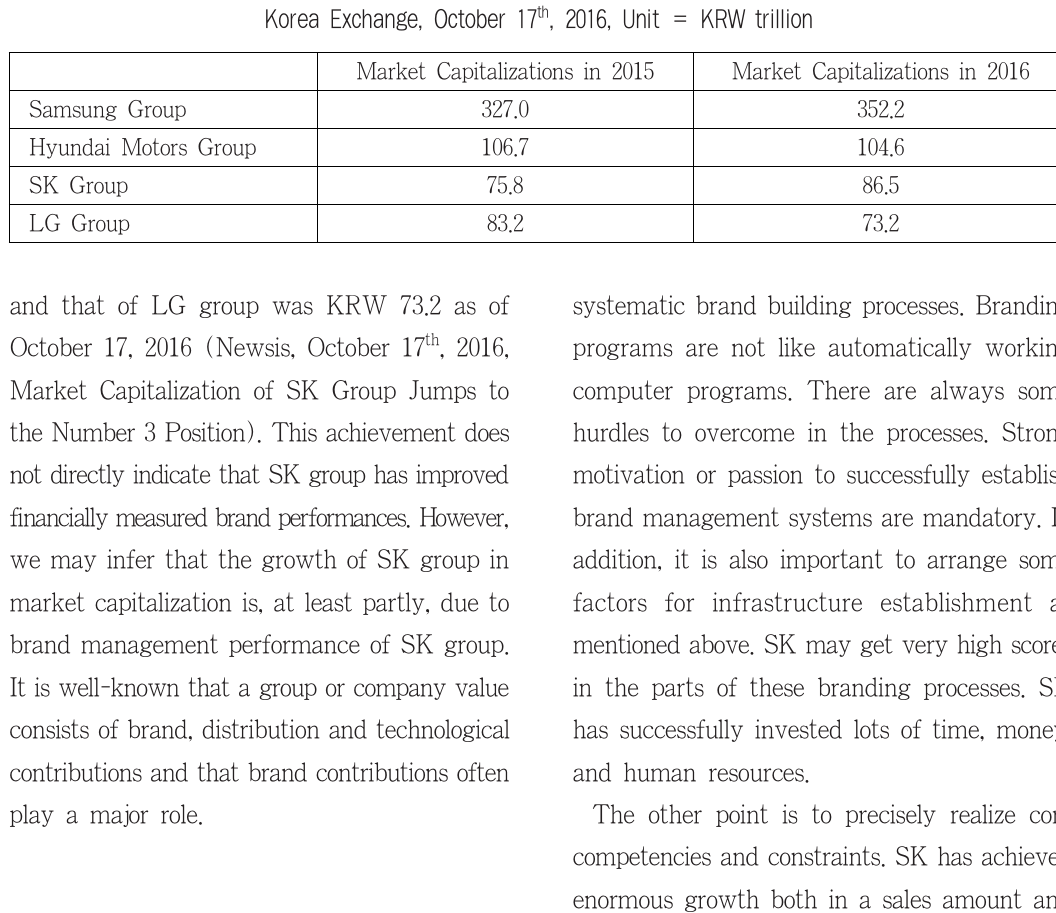
<Table 5> Markets Capitalizations of the largest 4 business groups in Korea in 2015 and in